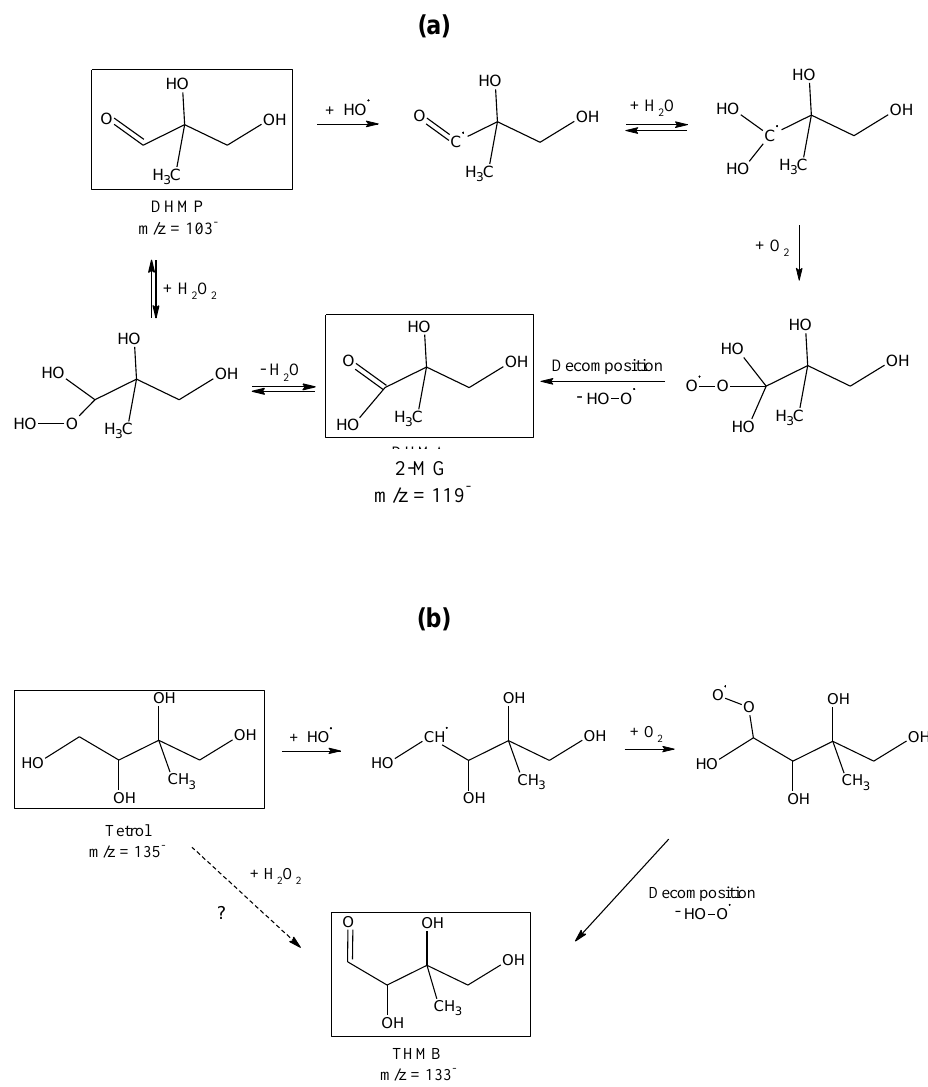
Fig. 8. Chemical mechanism of aqueous phase oxidation by H 2 O 2 and by OH radicals of (a) 2,3-dihydroxy-2-methyl-propanal (DHMP) leading to 2,3-dihydroxy-methacrylic acid (2–MG); and (b) 2-methylbutane-1,2,3,4-tetrol (tetrol) leading to trihydroxy-3-methylbutanal (THMB).